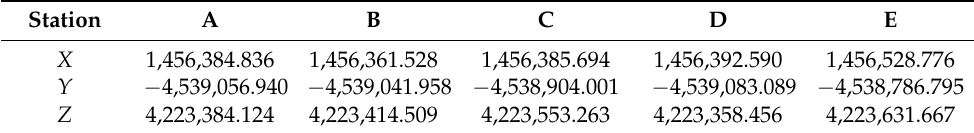
Table 1. Randomly generated coordinates for five control stations around